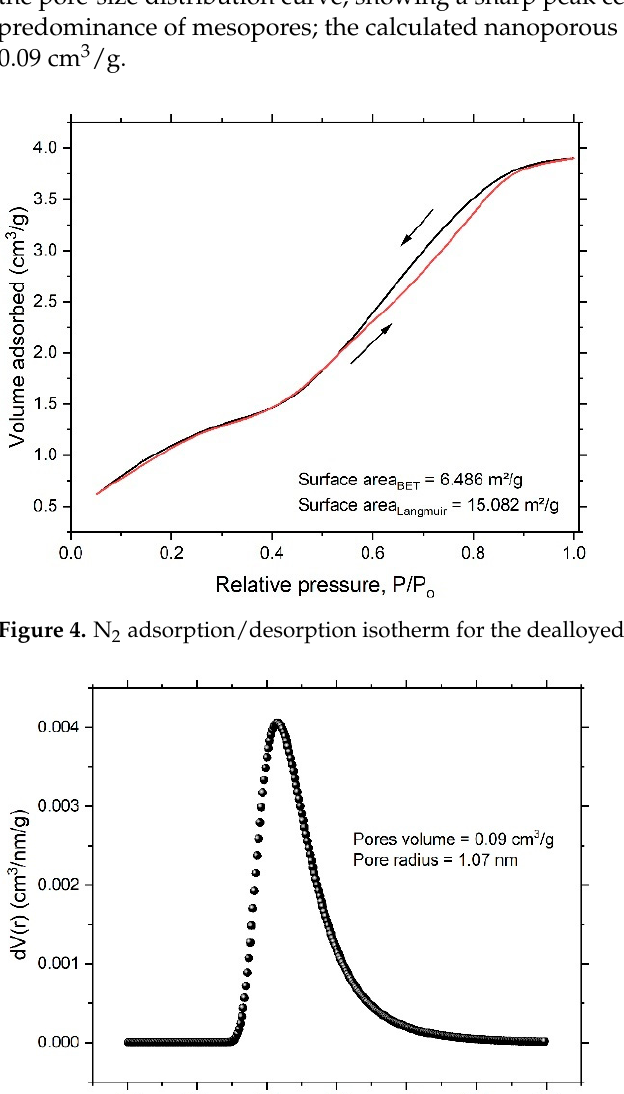
Figure 6. Cyclic voltammetry curves of the dealloyed glassy alloy ribbon sample at different scan- ning rates, as indicated.